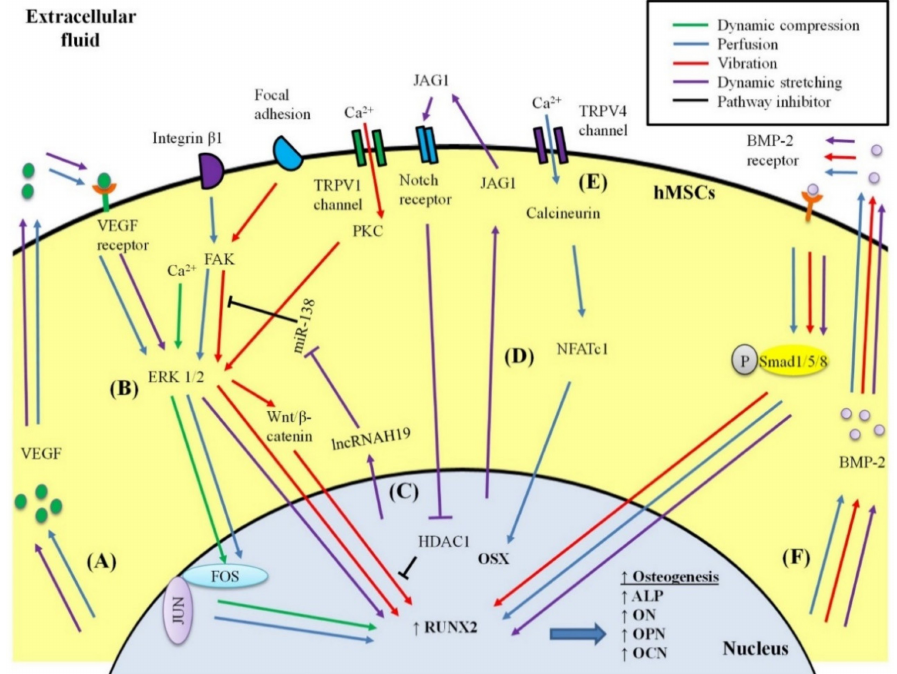
Figure 3. Mechanotransduction signalling for osteogenesis of human mesenchymal stem cells (hMSCs). ( A ) VEGF signalling pathway: VEGF is produced and released into extracellular fluid to bind to